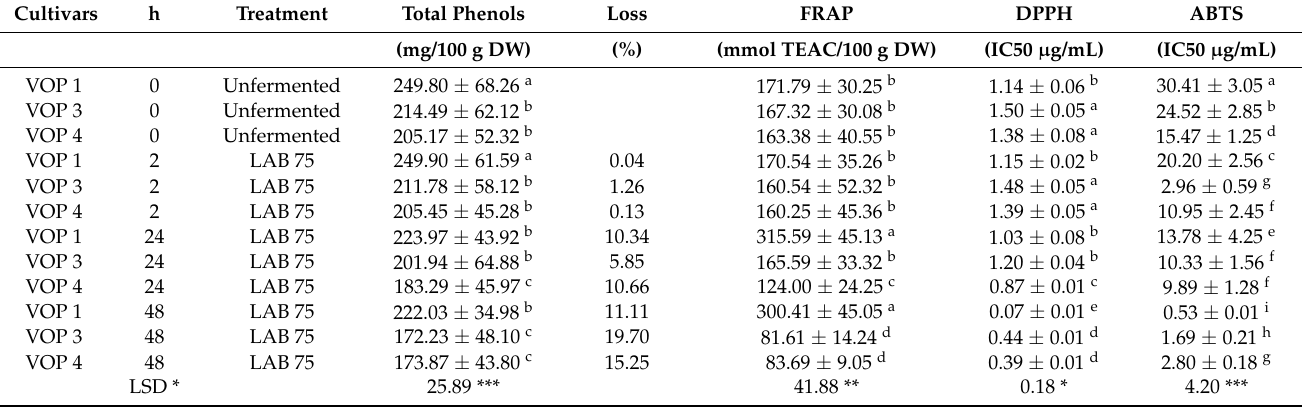
Table 4. Antioxidant properties and total phenol content of fermented and unfermented cowpea leaf smoothies obtained from three